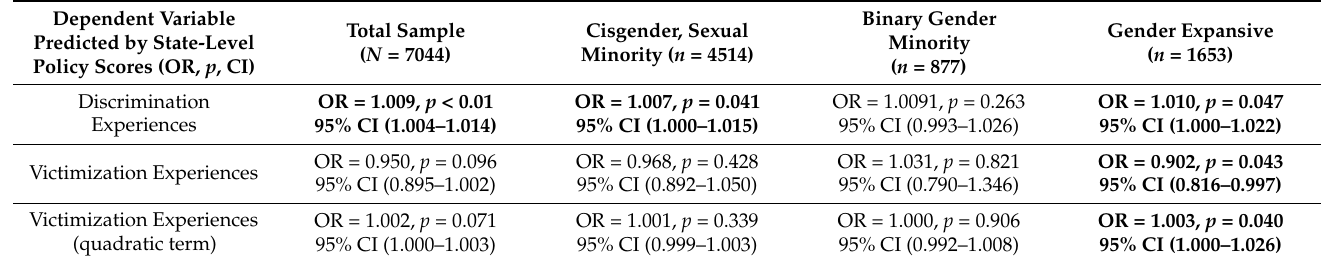
Table 2. Results of logistic regression models examining the relationship between state-level pol- icy environment scores and past-year discrimination and victimization within The PRIDE Study ( N = 7044).